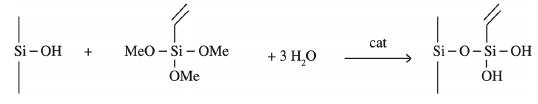
Figure 1. Functionalization reaction of the fillers.